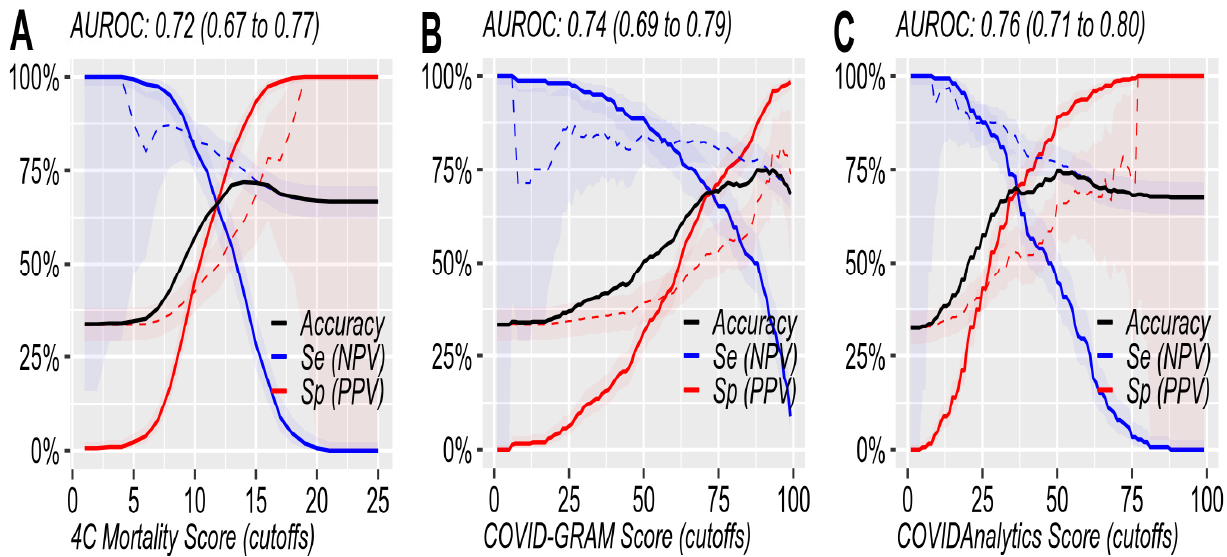
Figure 2. The parameters of the three mortality prediction scores for all the cut-offs. ( A )—4CM Score, ( B )—COVID-GRAM, and ( C )—COVIDAnalytics. Black line: diagnostic accuracy; solid blue line: sensitivity; dashed blue line: negative predictive value; solid red line: specificity; dashed red line: positive predictive value.